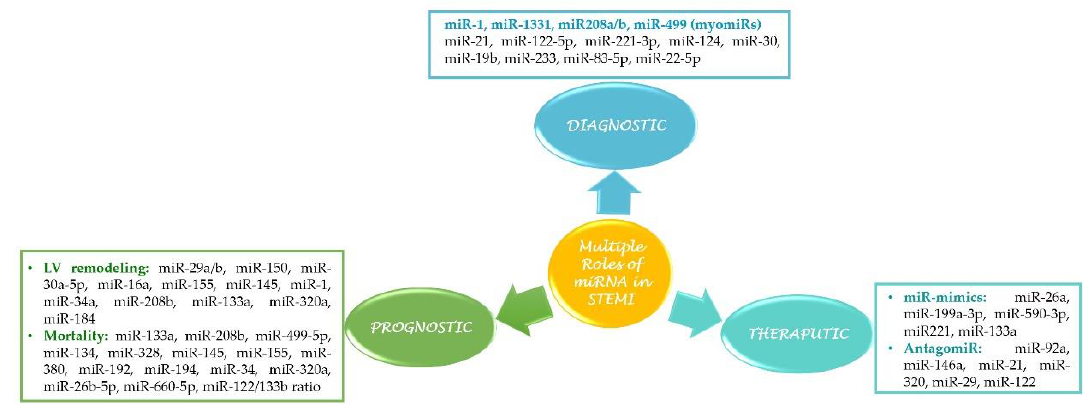
Figure 2. Multiple roles of miRNA in STEMI.